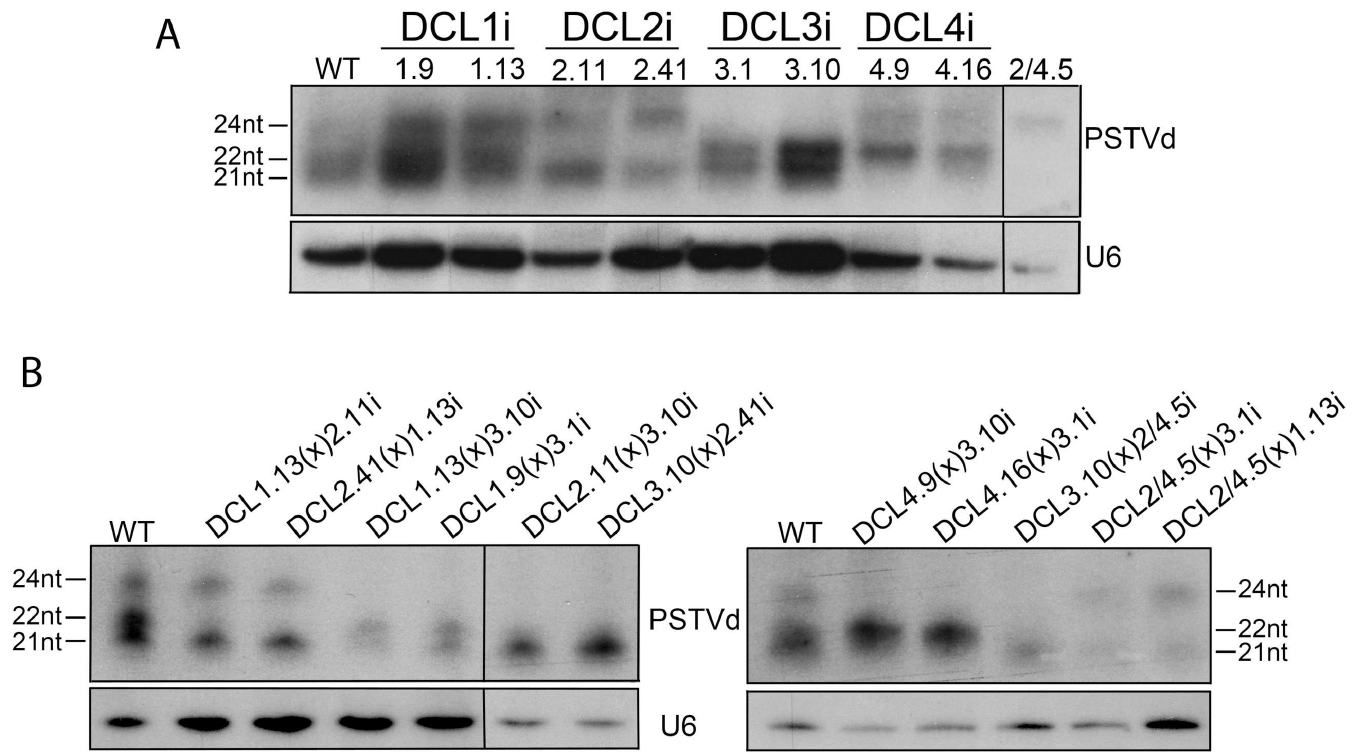
Fig 3. vd-siRNAs profiling in DCLi single or crossed plant lines. Small RNAs from 3 weeks infected N . benthamiana plants were analyzedin polyacrylamide gels and 21, 22 and 24nt of PSTVd were monitored. U6 was used as a loadingcontrol. In panel (A) DCLi single knock-downlines and in (B) DCLi F1 crosses. Quantification of small RNAs were made using Quantity One 4.4.1 shown in S2 Table.